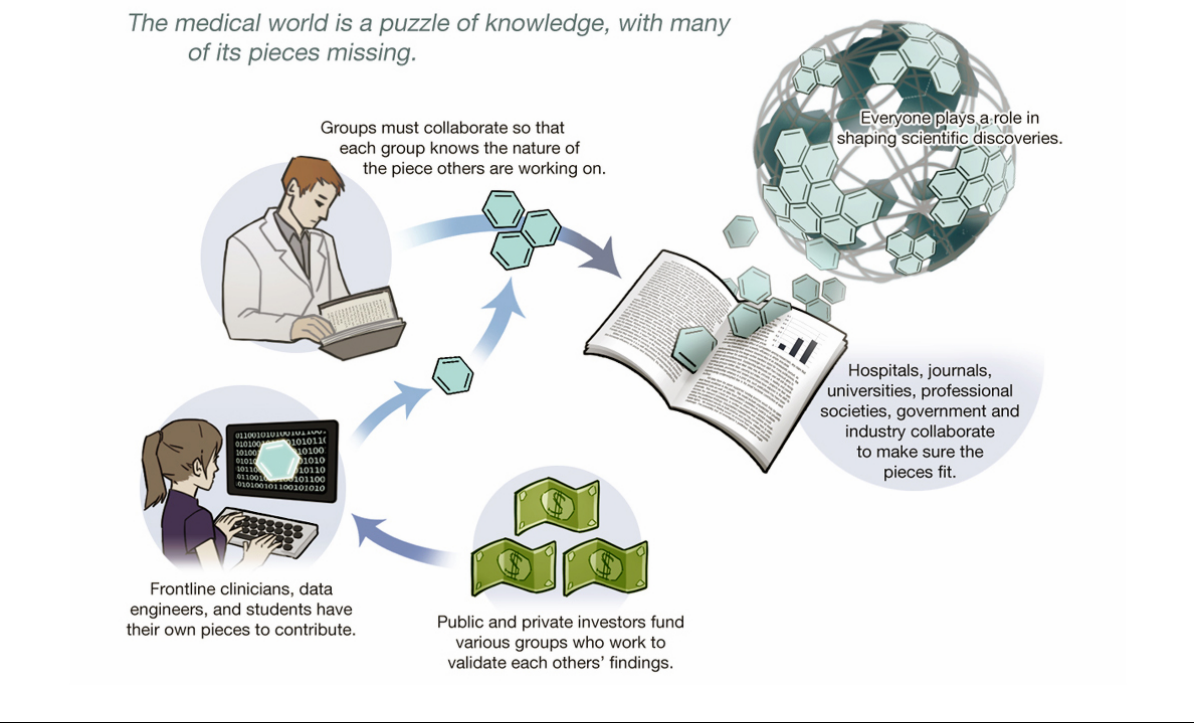
Figure 2. Graphic illustrating how to address unreliable research. Figure courtesy of Kai-ou Tang.